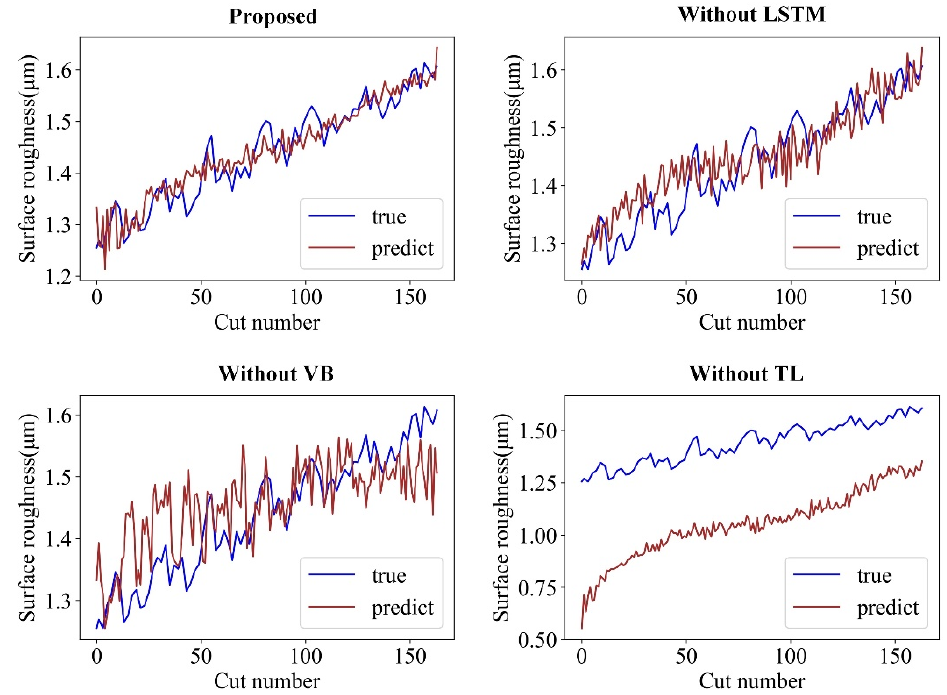
Figure 15. Prediction effect of different models on CT2-2 of the T1 task.